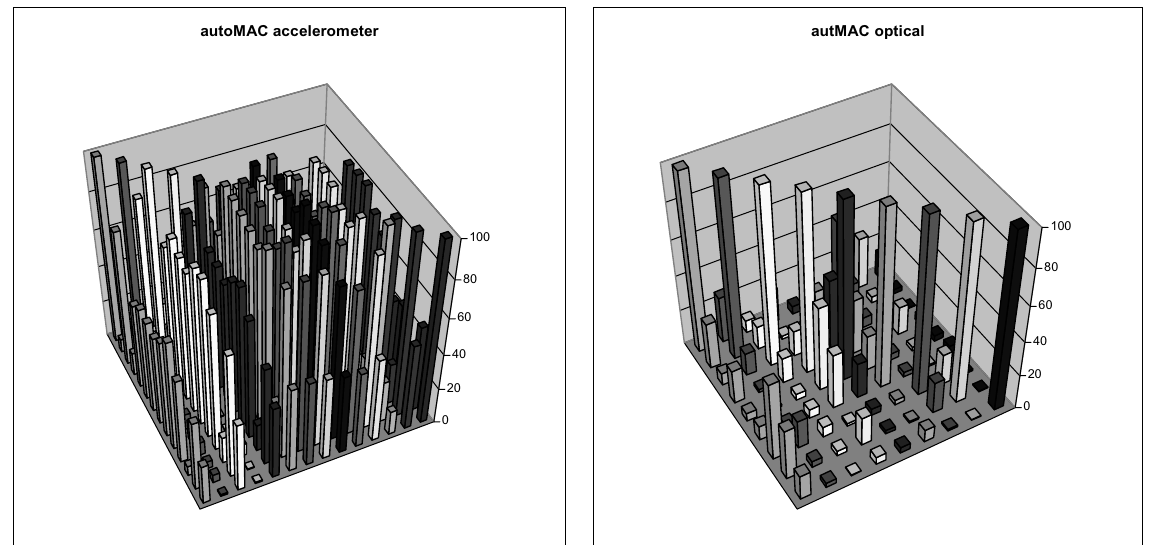
Fig. 17. AutoMac Matrices (L) accelerometer based measure, (R) optical based measure. to the ones obtained with the other contact-less